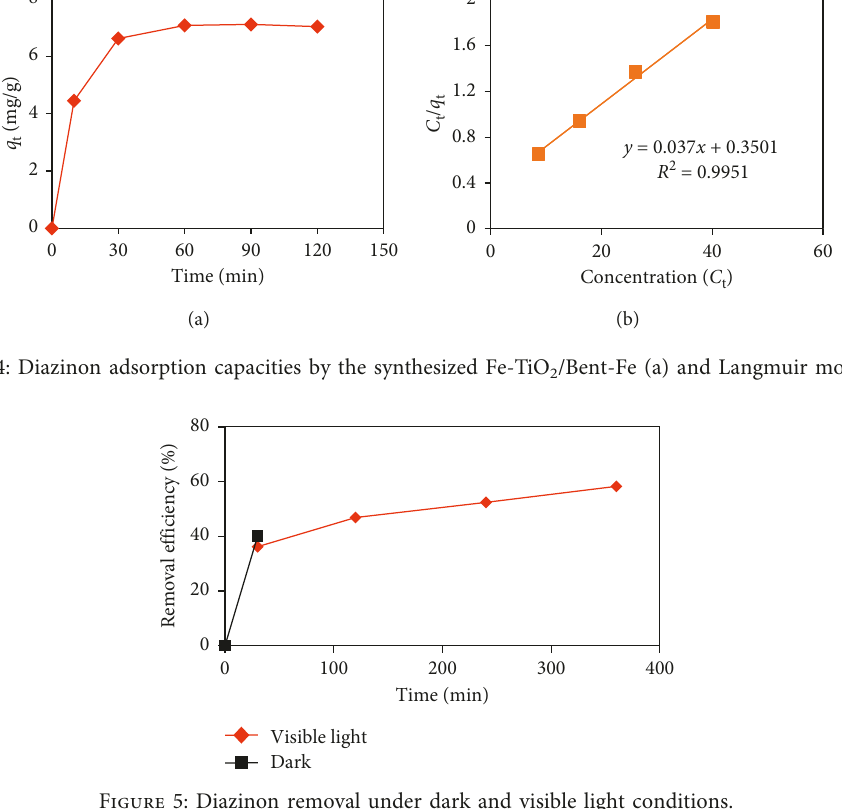
Figure 5: Diazinon removal under dark and visible light conditions.